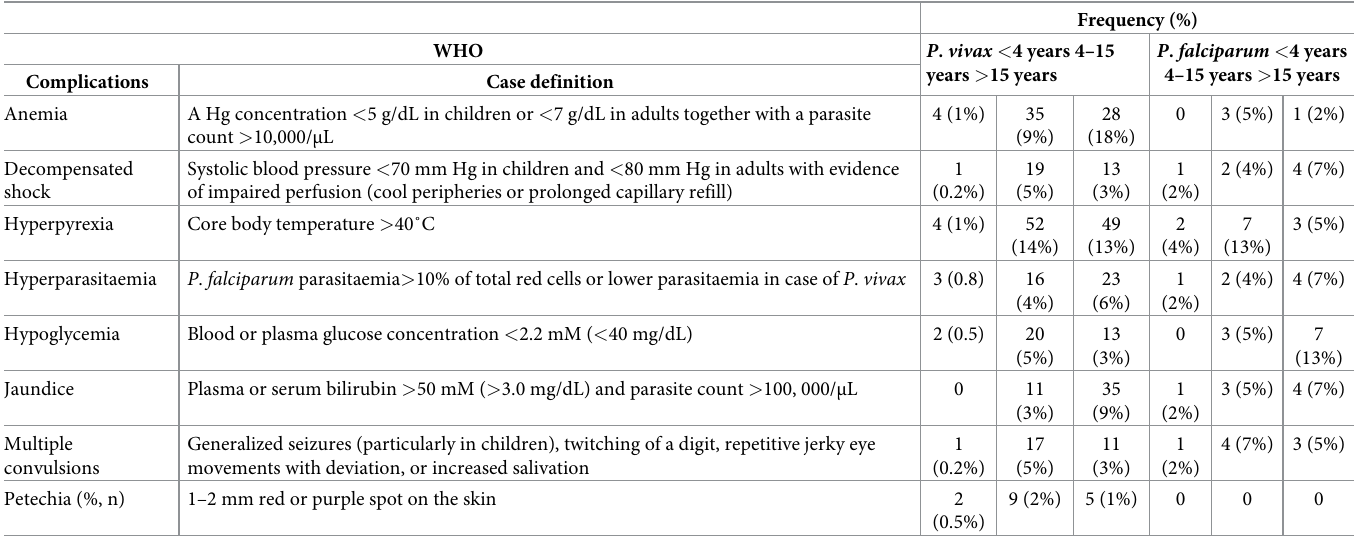
Table 4. Comparison of complication rates in P . vivax versus P . falciparum infection, Tribal districts, KPK province, Pakistan, 2016–2018 [18,